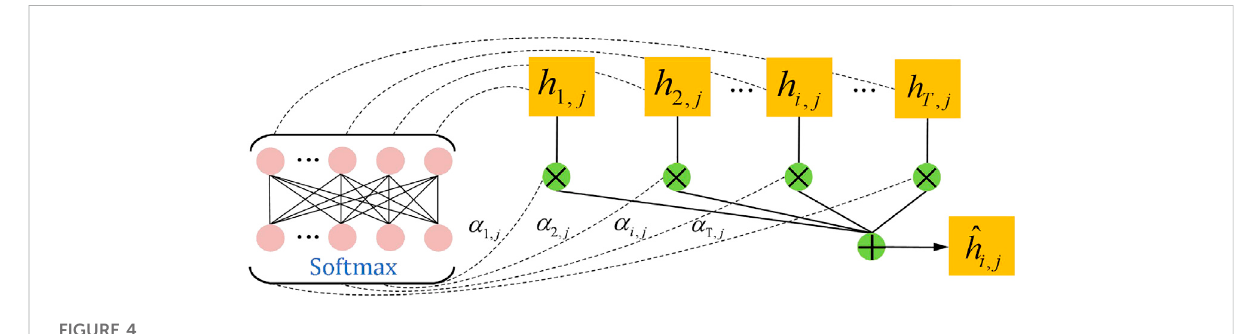
FIGURE 4 Structure of the attention